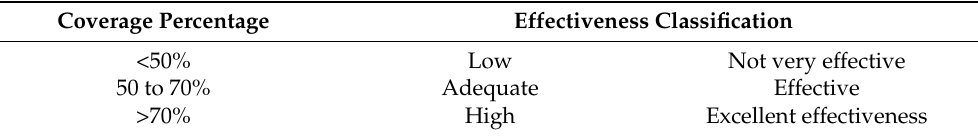
Table 1. Criteria for evaluating the effectiveness of health programs and systems. Coverage Percentage Effectiveness Classification <50% Low Not very effective 50 to 70% Adequate Effective >70% High Excellent effectiveness Source: Hartz and Silva [28].